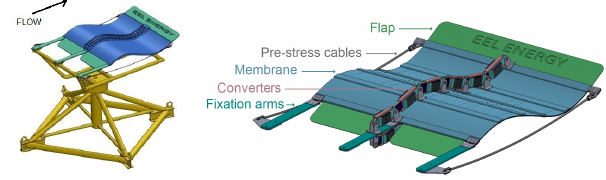
Fig. 1. CAD representation of an undulating membrane tidal energy